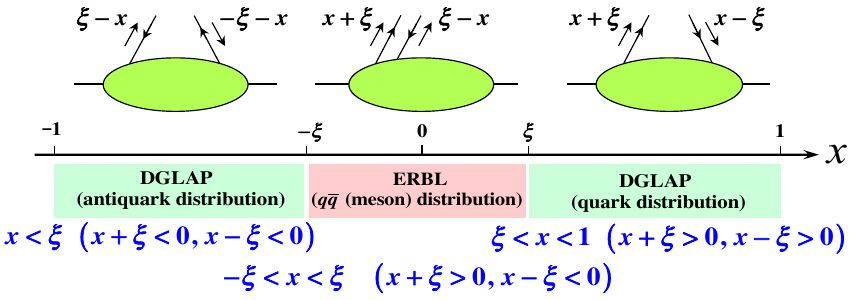
Figure 10. DGLAP and ERBL regions of GPDs. See text for